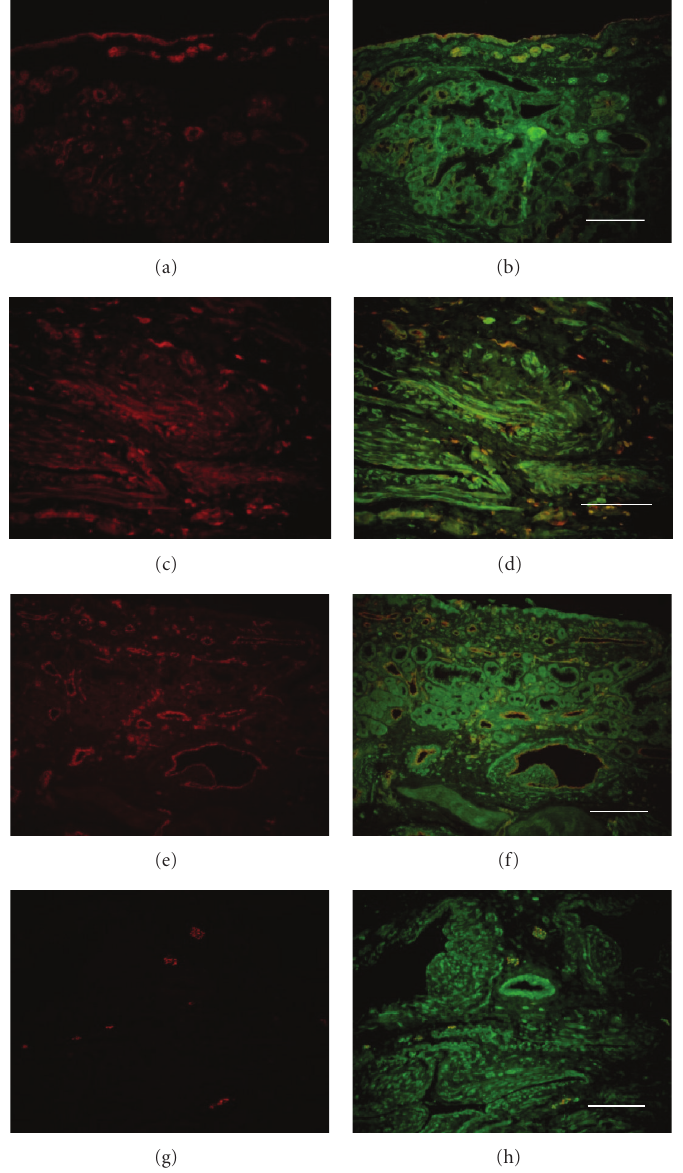
Figure 4: Identification of subsets of cells expressing the B2 receptor in human allergic nasal mucosa. Single staining immunofluorescence for each cell type (panel (a), (c), (e), and (g) and the dual staining for the cell marker and B2 receptor (panel (b), (d), (f), and (h). The B2 receptor protein (green) shows colocalization with antiphenotypical marker antibody (red) and the combined signal is visualized as yellow. Identification markers for cytokeratin (epithelial cells) (a), (b); fibroblast (c), (d); CD31 (vascular endothelial cells) (e), (f); neurofilament protein (peripheral nerves) (g), (h). Scale bar = 100 μ